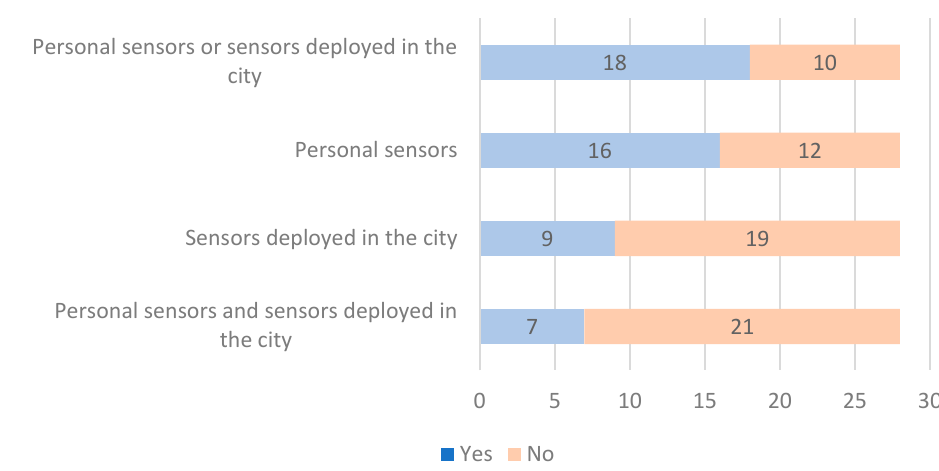
Figure 5. Number of articles reporting data gathered by personal sensors and sensors deployed in the city.